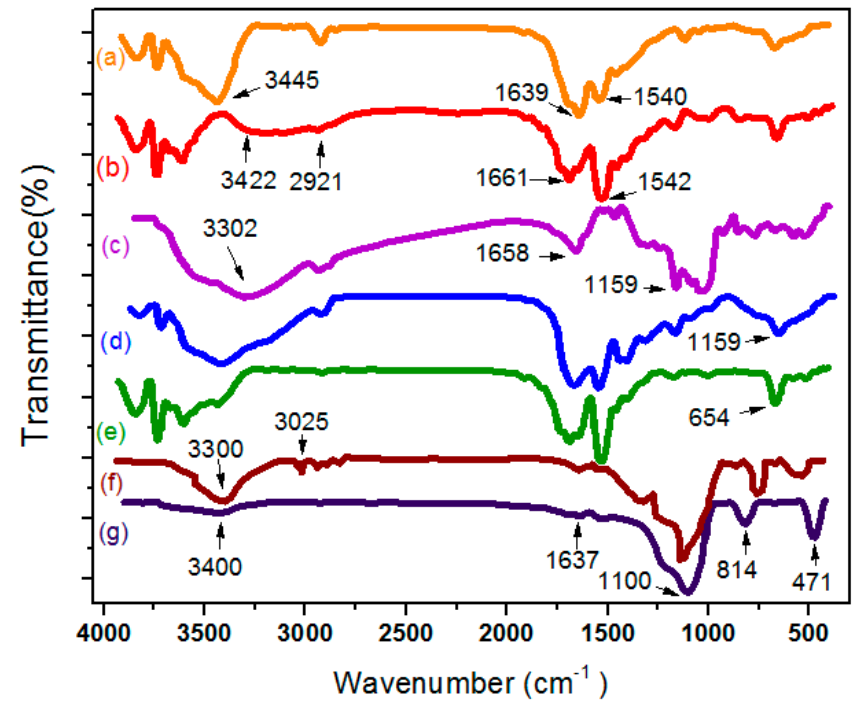
Figure 6. FTIR spectra for: PAAm ( a ), copolymeric hydrogel ( b ), PAAc ( c ), nanocomposite microgel ( d ), core-shell microgel ( e ), nano- SiO 2 functional monomer ( f ), nano- SiO 2 particles ( g ).